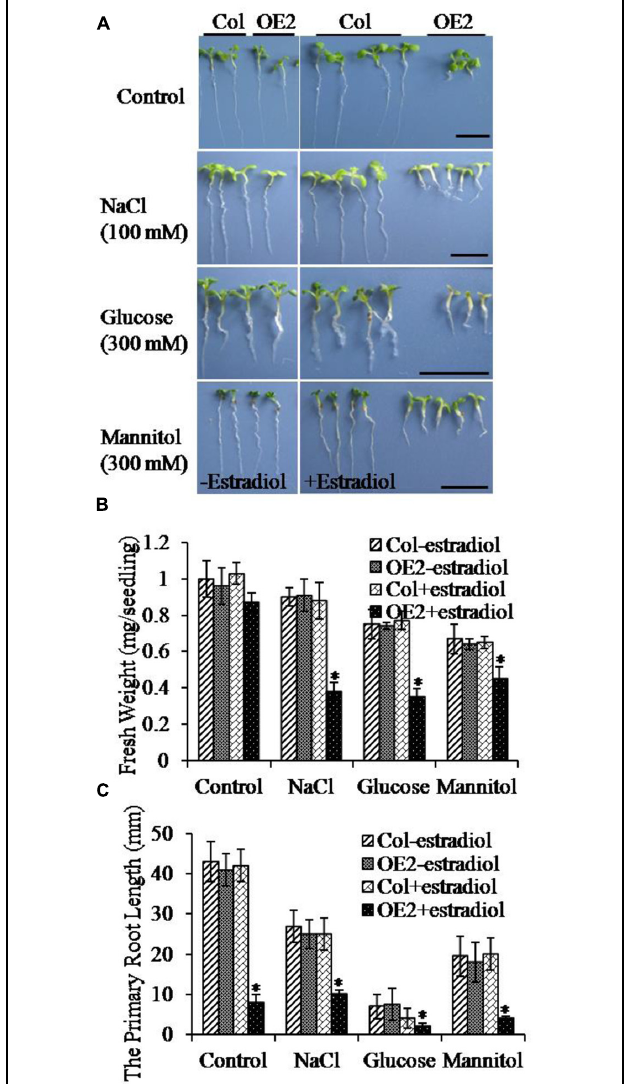
FIGURE 2 | The growth of cotyledons and primary roots of OE2 seedlings was altered under various stress conditions. Asterisk symbols ( ∗ ) indicate p < 0.05 (Student t- test). (A) The OE2 seedlings showed hypersensitivity to treatments of NaCl, glucose and mannitol. Seeds were germinated on the indicated plates, and photos were taken after 10 days of seedlings grown on the indicated plates. Bar = 10 mm. Estradiol: 17- β -estradiol (10 μ M). (B) The fresh weights of Col and OE2 seedlings were quantified. The values were determined by using the data from three independent experiments (seedling numbers, n > 20 per experiment). (C) The primary roots lengths of Col and OE2 seedlings were measured. The values were determined by using the data from three independent experiments (seedling numbers, n > 20 per